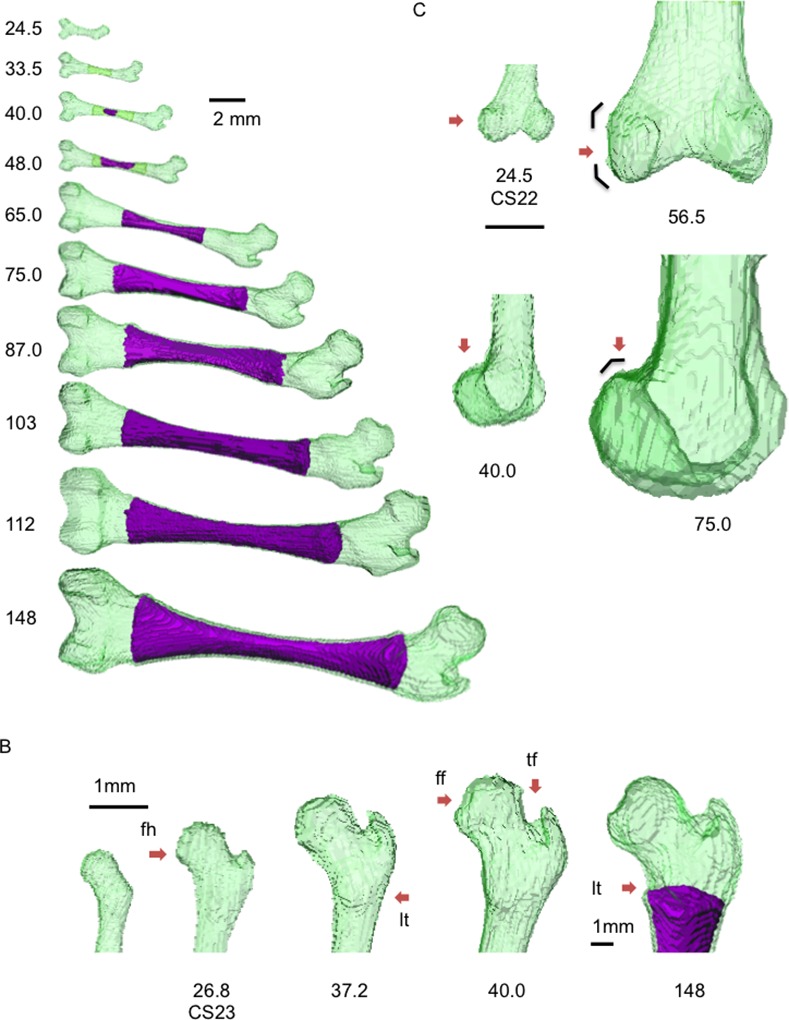
Representative 3-D reconstruction of the right femur from the embryonic period to the early fetal period.(A) Gross view, (B) proximal epiphysis (posterior view), (C) distal epiphysis. Numbers represent the crown–rump length (mm). Ossified region is indicated as purple. ff: femoral head fovea; fh: femoral head; lt: lesser trochanter; tf: trochanteric fossa. See also S7, S8 and S9 Movies.